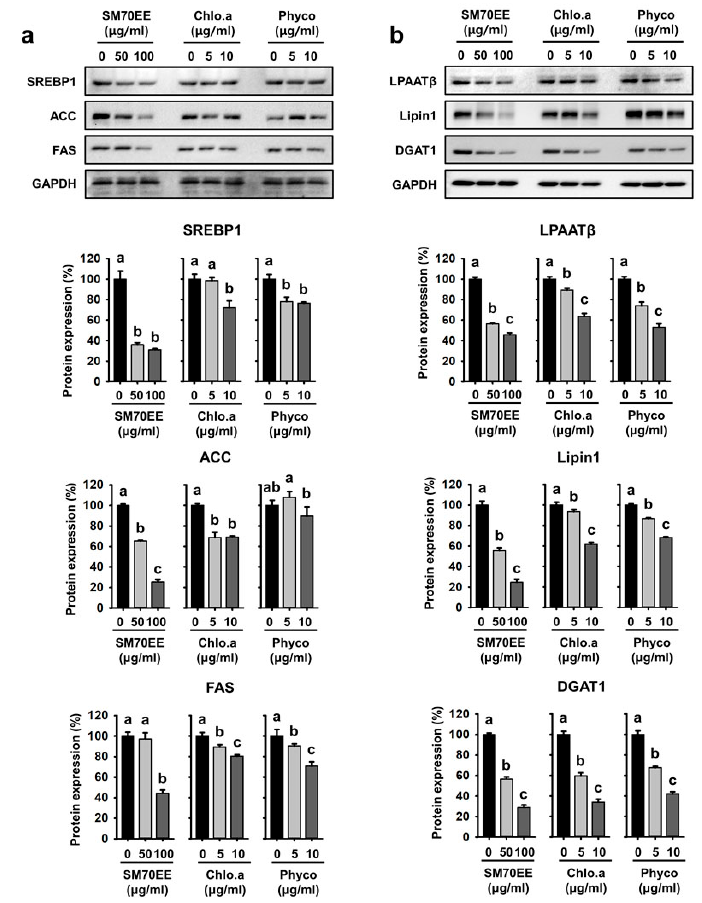
Figure 2. SM70EE, chlorophyll a, and C-phycocyanin regulate lipogenesis pathway enzyme expression in 3T3-L1 cells. ( a ) Western blots of SREBP1, ACC, and FAS protein expression after differentiation for 8 days. Specific bands were quantified and these are presented as graphs. ( b ) Representative western blots of lipogenic proteins (LPAAT β , lipin1, and DGAT1) in 3T3-L1 adipocytes. Data are expressed as mean ± SD ( n = 3). Values with different letters are significantly different, p < 0.05 (a > b > c).